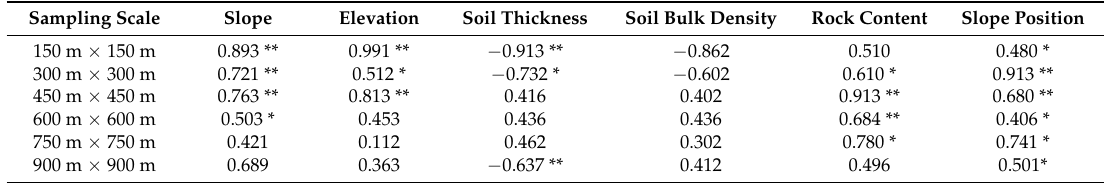
Table 3. Correlation matrix of rock exposures and its influencing factors under different sampling scales. Sampling Scale Slope Elevation Soil Thickness Soil Bulk Density Rock Content Slope Position 150 m × 150